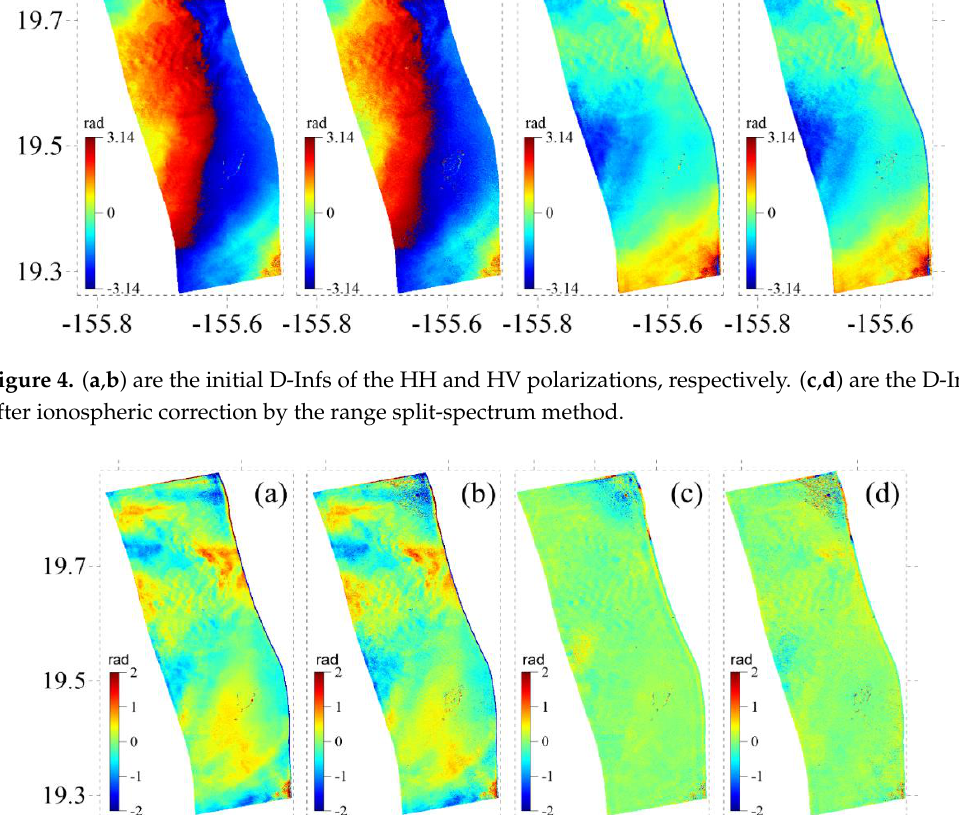
Figure 4. ( a ) and ( b ) are the initial D-Infs of the HH and HV polarizations, respectively. ( c ) and ( d ) are the D-Infs after ionospheric correction by the range split-spectrum method.